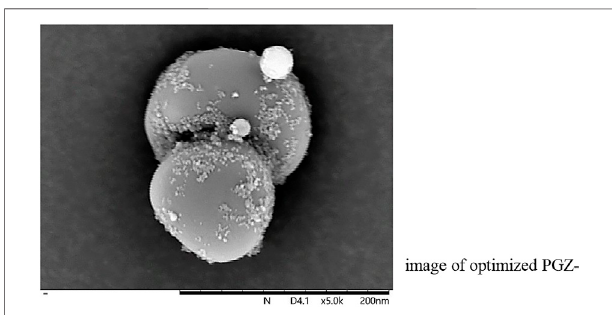
FIGURE 2 | SEM image of optimized